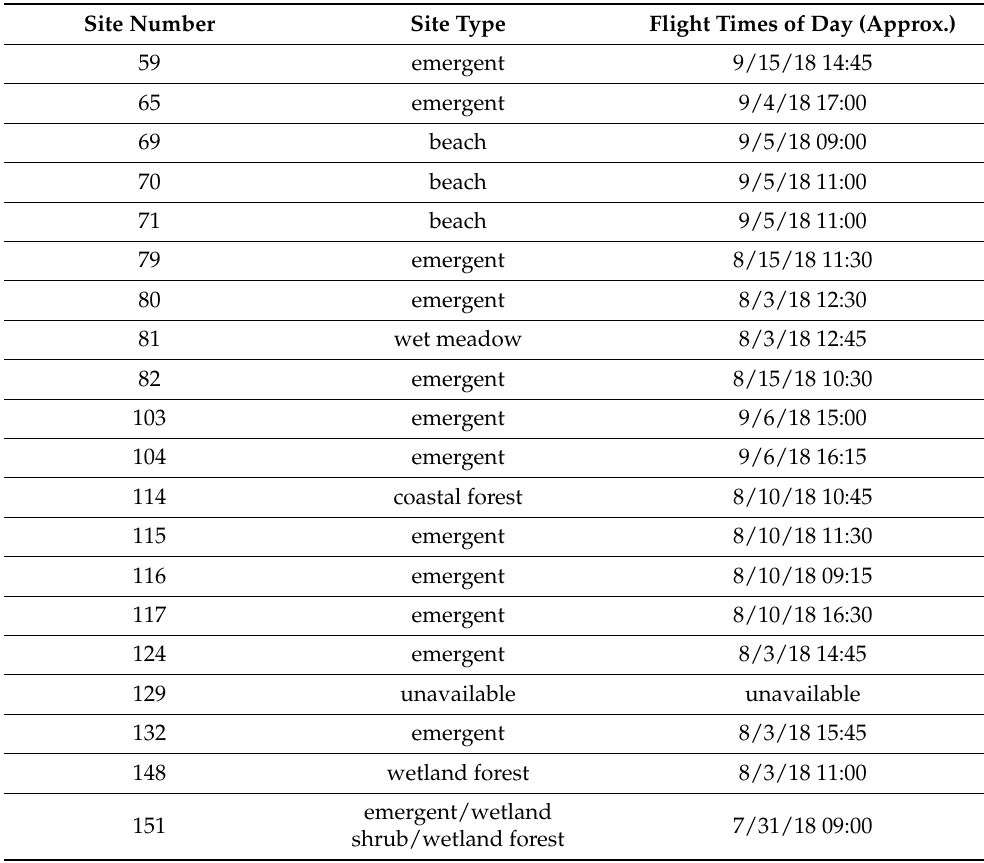
Table 2. Study site characteristics, including type of site and approximate flight